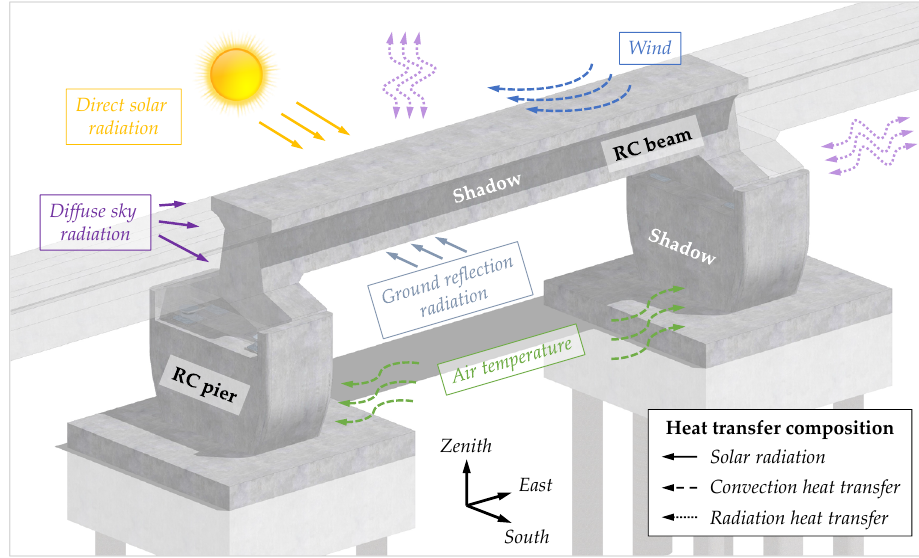
axis points to the geographical south direction, the -axis points the geographical east direction, and the -axis points to the zenith and is perpendicular to the horizontal plane. 𝑂𝑂 Figure 1. Heat flow schematic diagram of the maglev bridge. Figure 1. Heat flow schematic diagram of the maglev bridge. Figure 1. Heat flow schematic diagram of the maglev bridge. 𝑂𝑂